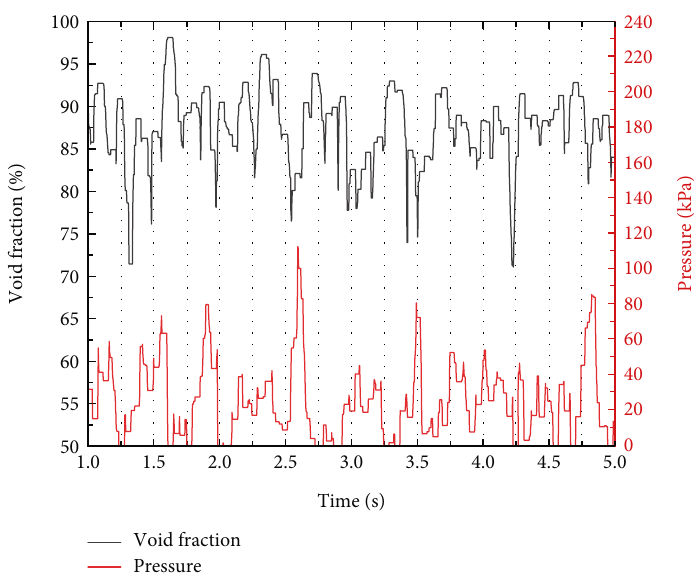
Figure 9: Variation curve of cross-sectional void ratio and